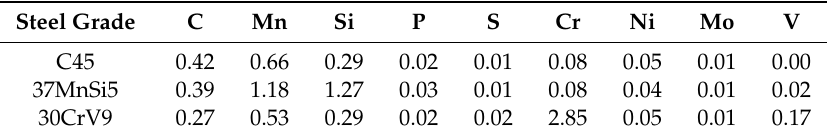
Table 1. Chemical composition of examined steels in wt. %.